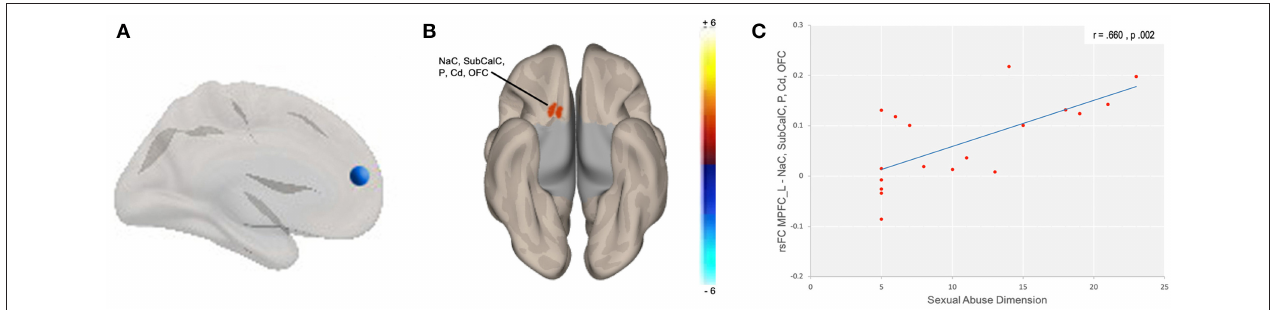
FIGURE 3 | Correlation between sexual abuse and functional connectivity. Correlation between subdimension of sexual abuse and functional connectivity in (A) left medial prefrontal seed in BPD patients with (B) NaC, accumbens; Cd, caudate; OFC, orbitofrontal cortex; P, putamen; SubCalC, subcallosal Cortex; cluster: x = − 06, y = + 10, z = − 10; (C) Correlation between subdimension of sexual abuse and connectivity